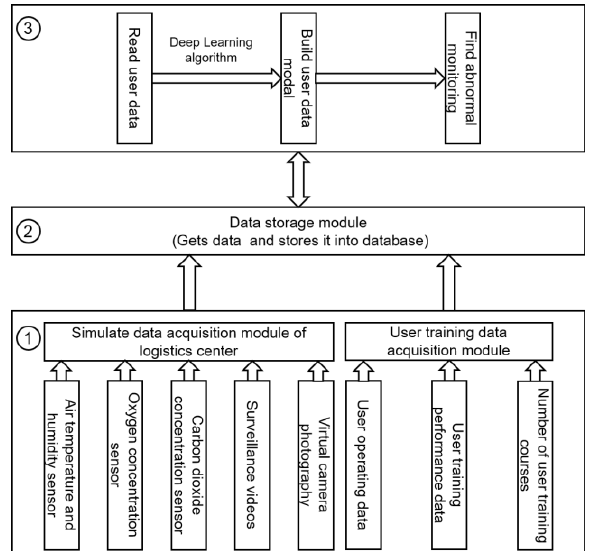
Figure 1. VR Based Logistic Centre Information Integration